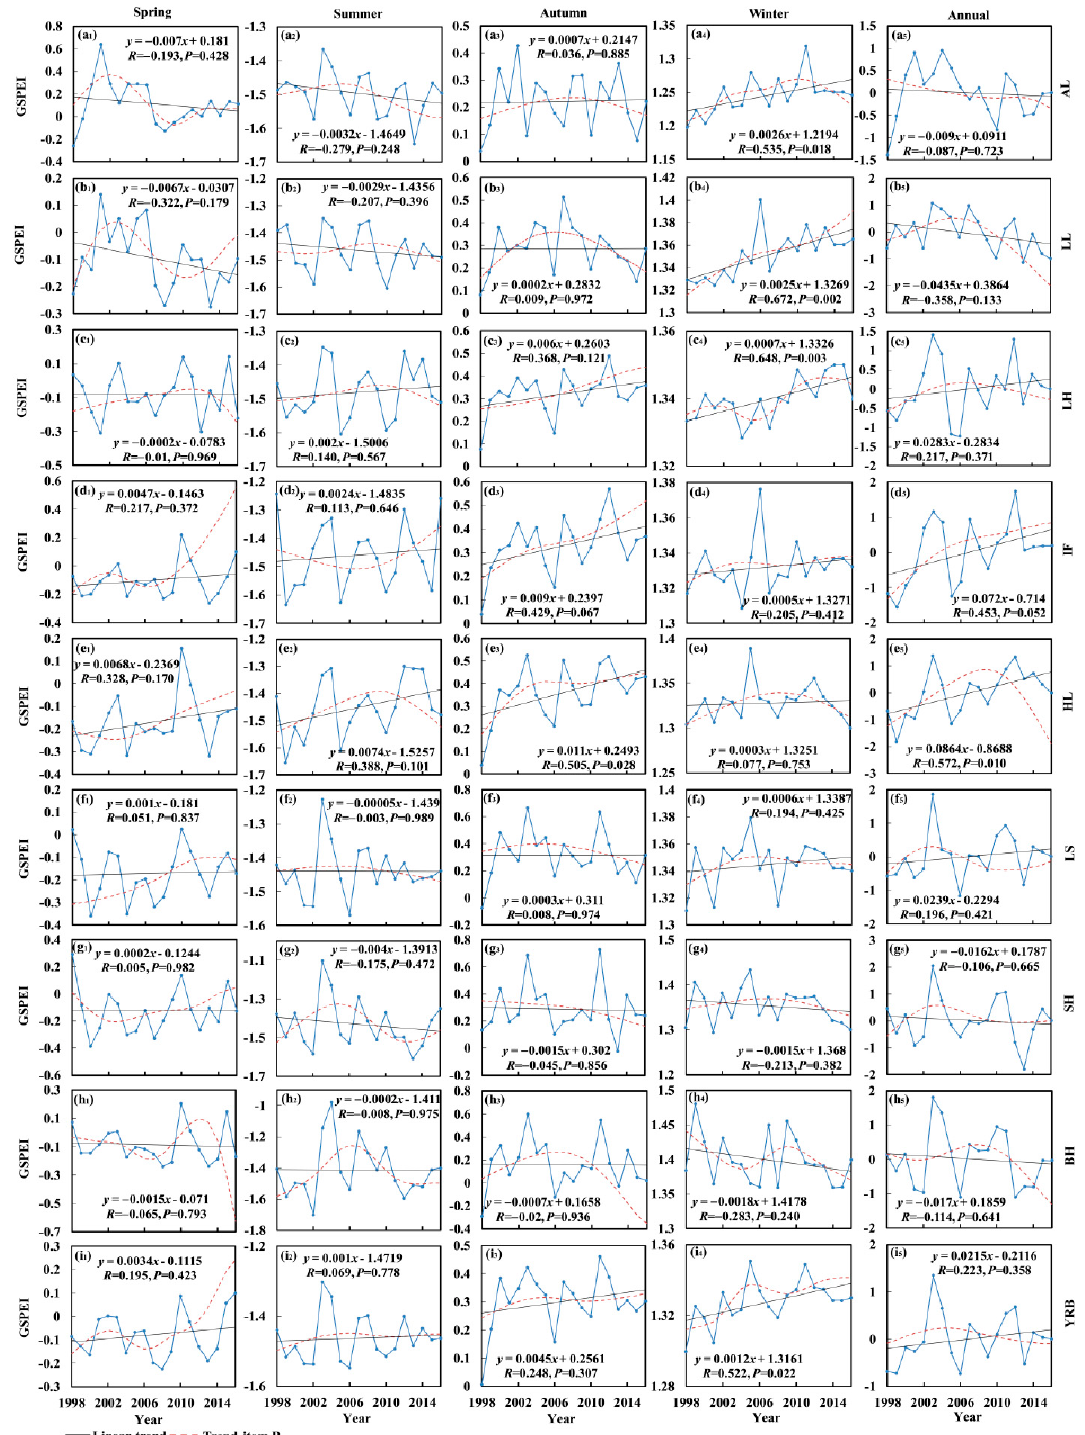
Figure 6. Temporal characteristics of drought in the Yellow River basin (YRB) during 1998–2016. The eight subzones are: AL ( a 1 – a 5 ), LL ( b 1 – b 5 ), LH ( c 1 – c 5 ), IF ( d 1 – d 5 ), HL ( e 1 – e 5 ), LS ( f 1 – f 5 ), SH ( g 1 – g 5 ), and BH ( h 1 – h 5 ),